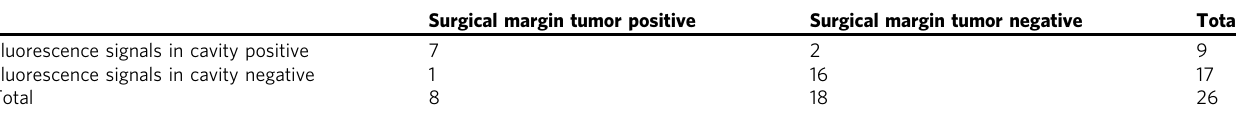
Table 2 Contingency table of molecular fl uorescence-guided surgery in breast cancer patients Surgical margin tumor